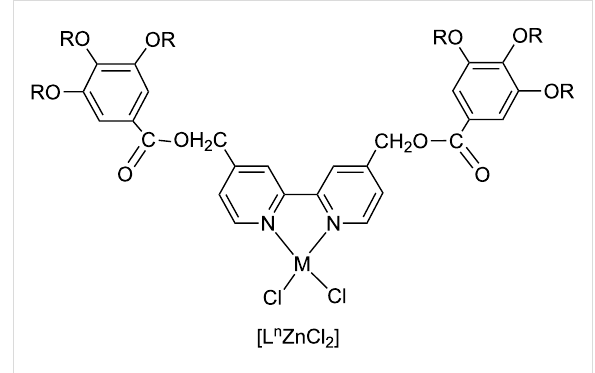
Figure 4: Molecular structure of Pt(II) complexes based on 4,4′-disub- ted 2,2′-bipyridines.